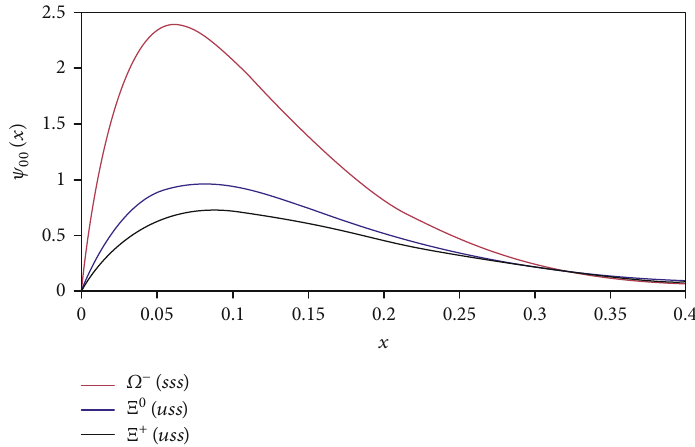
Figure 1: The hyperradius and